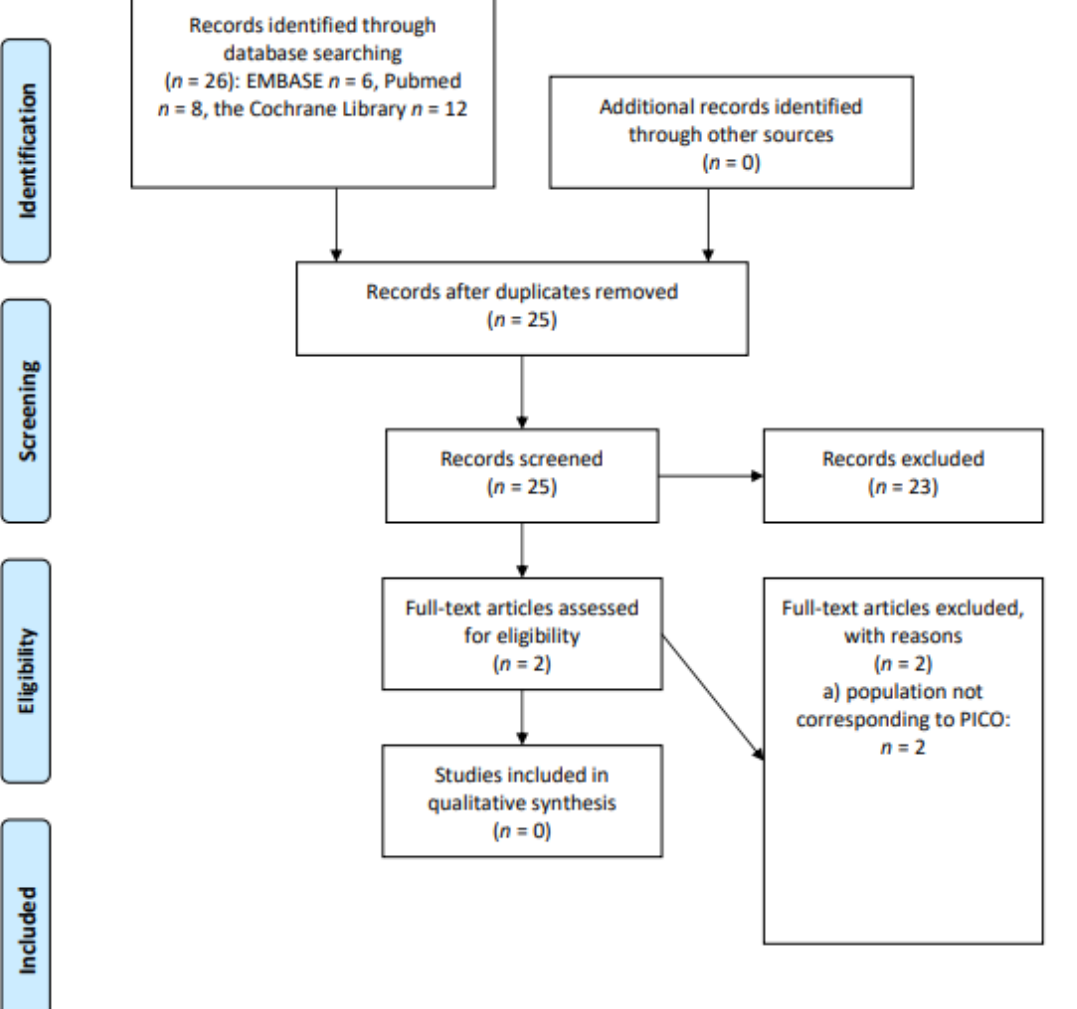
Figure 4. PRISMA flow-chart on dietary supplements.